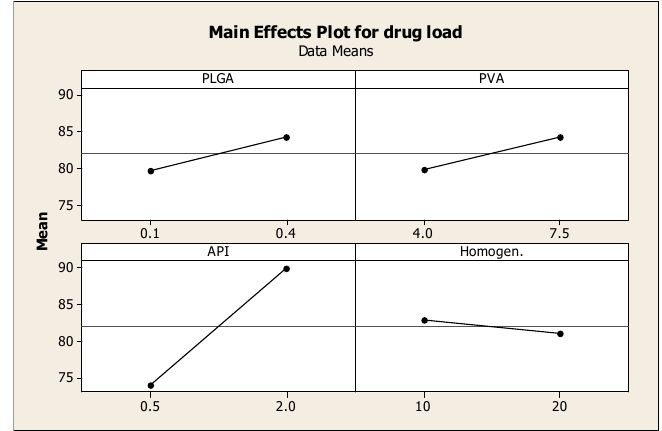
Figure 3. Main effects plot showing the effect of the four independent variables; PLGA, PVA, prednisolone concentrations and homogenization time on the drug loading into the nanoparticles.